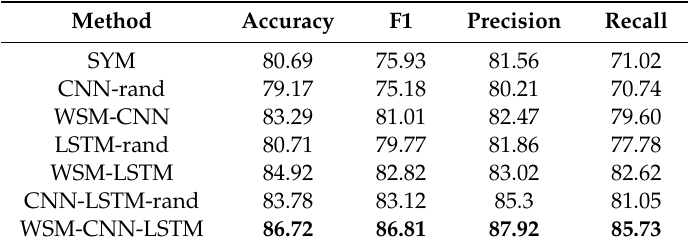
Table 2. ADR identification performance percentages when testing di ff erent comparison models.